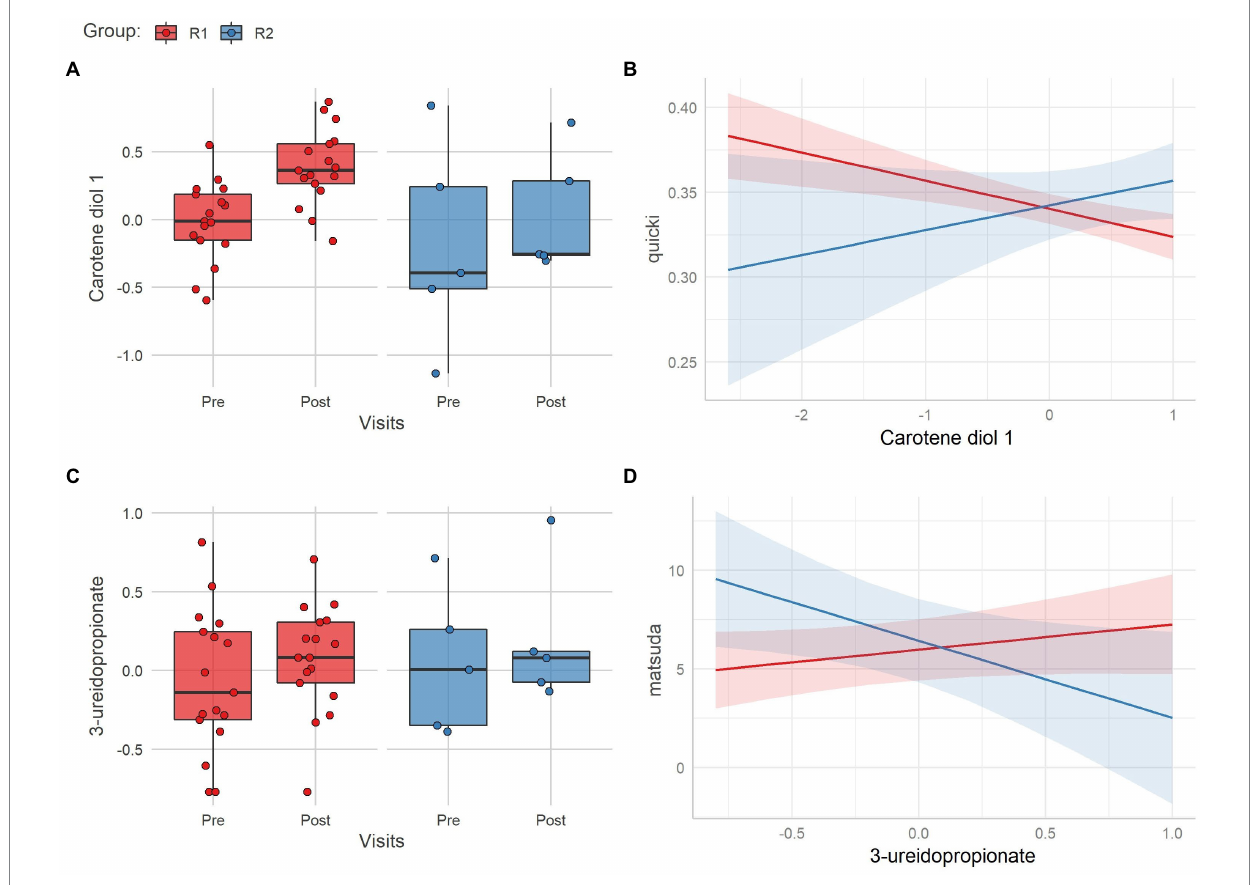
FIGURE 4 Association between changes in plasma metabolites and metabolic parameters during the intervention by response subgroup. Panels (A) and (C) show levels of carotene diol 1- and 3-ureidopropionate, respectively, for each response group, before and after the intervention. Panel (B) shows the changes of carotene diol 1 in relation to the changes in the QUICKI index for type 1 and type 2 responder groups. Panel (D) shows the changes in 3-ureidopropionate in relation to the changes in the Matsuda index for type 1 and type 2 responder